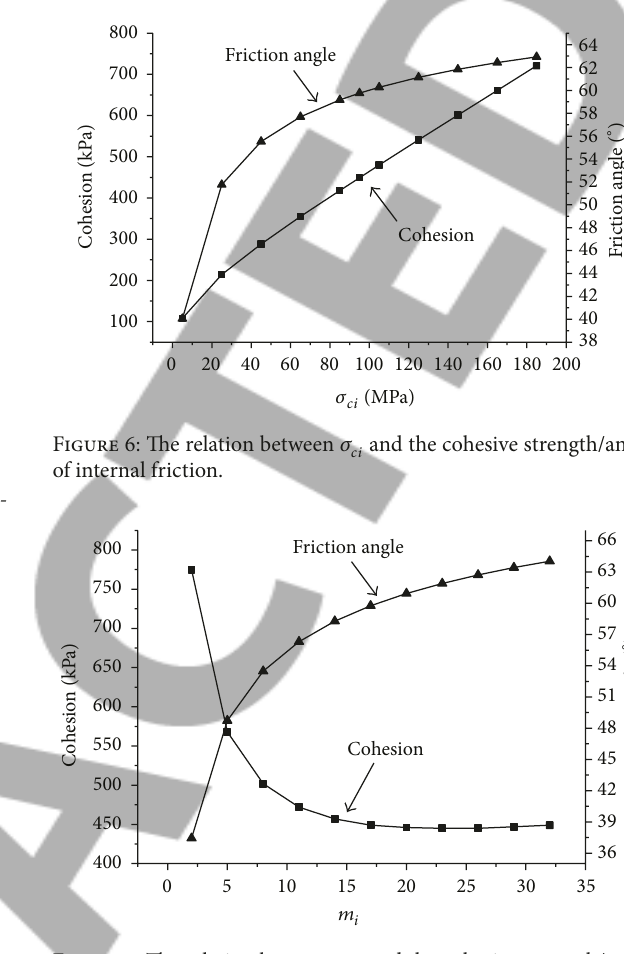
Figure 7: The relation between 𝑚 𝑖 and the cohesive strength/angle of internal